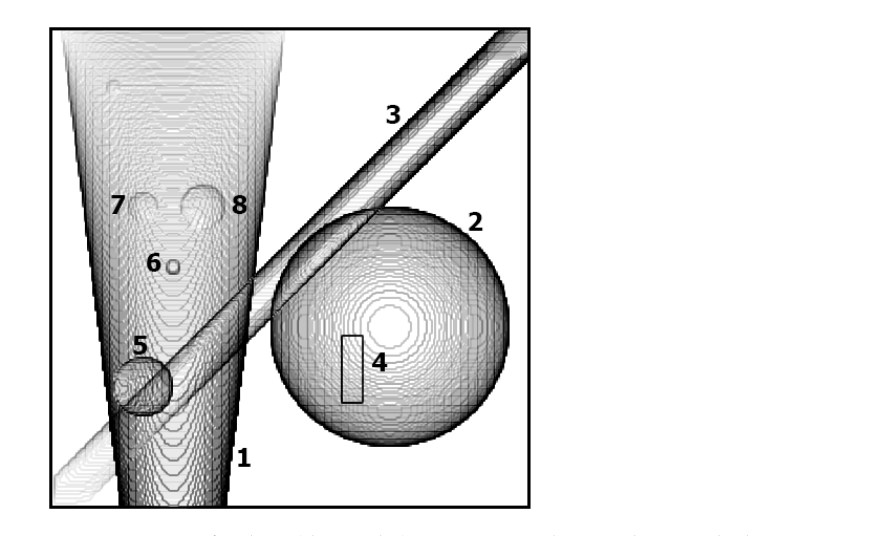
Figure 6. A 3D fandom (data cube) containing a large sphere with the same intensity (no. 2), a truncated cone with increasing intensity downwards (no. 1), an inclined cylinder with increasing intensity upwards (no. 3), a white parallelepiped inside the sphere (no. 4), and four spheres with various intensities inside the cone (nos. 5–8).